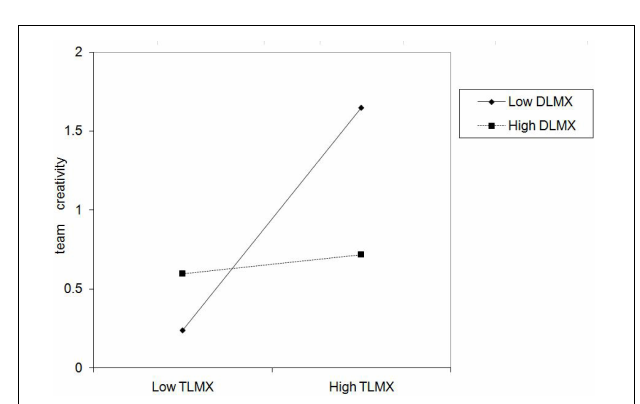
FIGURE 4 | Interaction of TLMX and DLMX on team